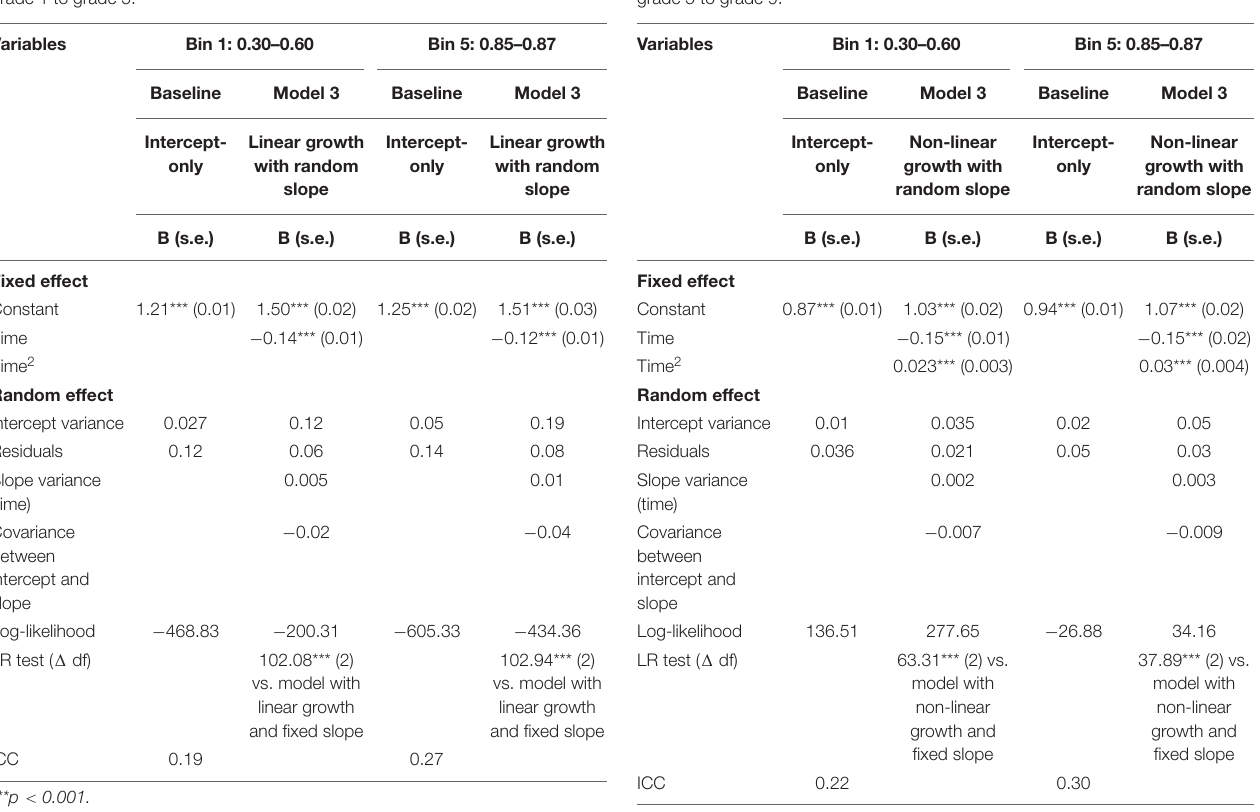
TABLE 11 | Cohort 2: results of ME growth models for changes in ANS RT (in sec.) for the easiest (0.30–0.60) and hardest (0.85–0.87) ratio bins from grade 5 to grade